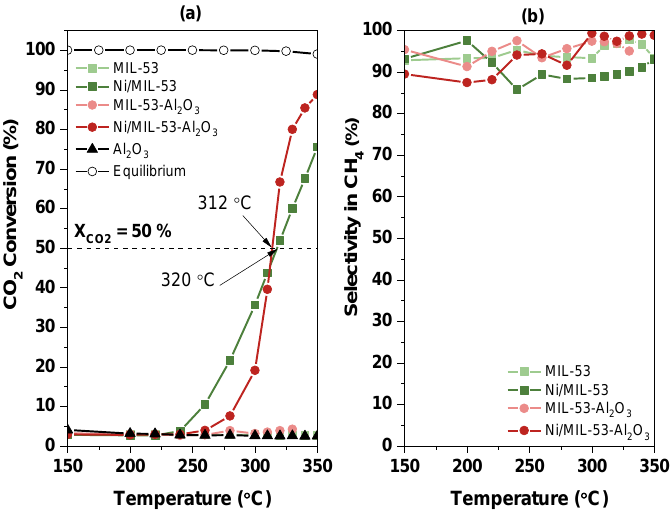
Figure 5. Temperature influence on the catalytic performance of the MIL-53-based samples in the methanation of CO 2 : ( a ) CO 2 conversion and ( b ) methane selectivity (CO 2 :H 2 = 1:5.2; [CO 2 ] = 6.6%, p = 1 atm, 2 °C/min, 4650 h −1 ).